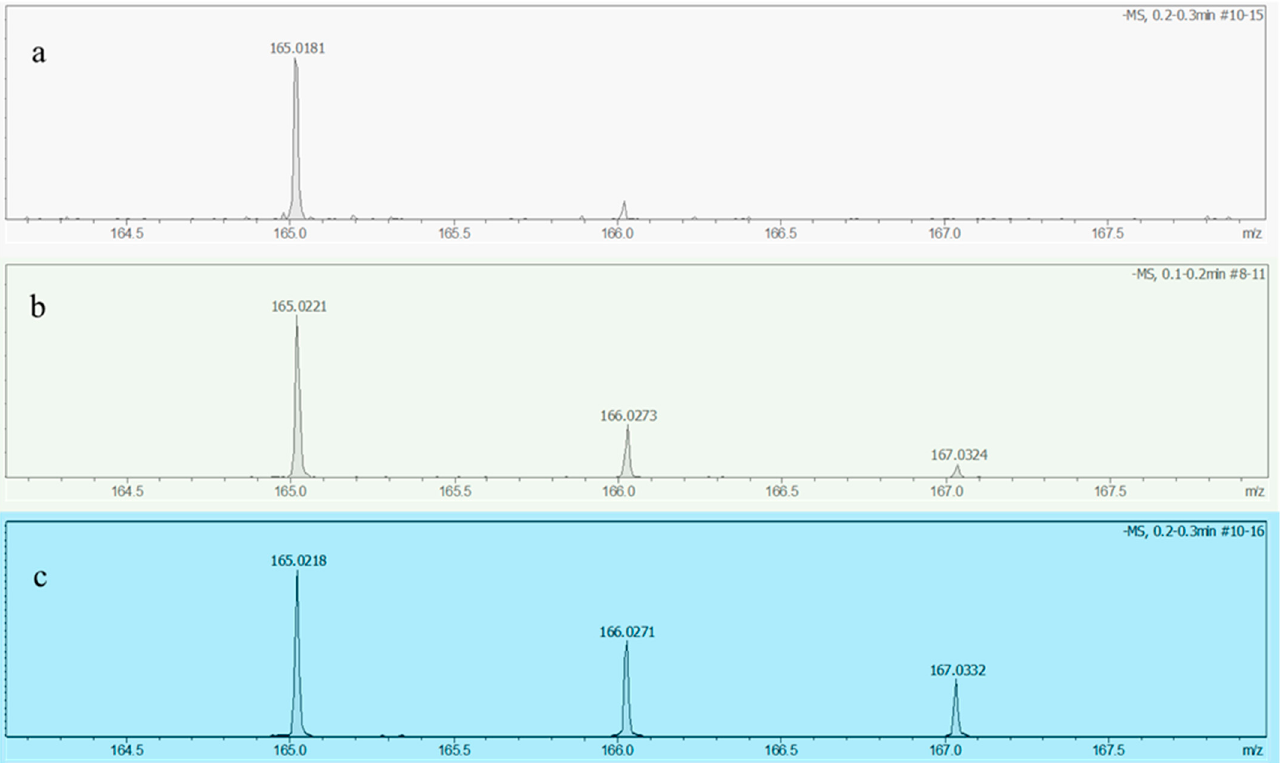
Figure 8. ESI–MS analysis of TPA obtained under different conditions: ( a ) TPA obtained by catalytic steam–assisted (H 2 O) pyrolysis of PET; ( b ) TPA obtained by steam-assisted (D 2 O) pyrolysis of PET without catalyst; ( c ) TPA obtained by catalytic steam-assisted (D 2 O) pyrolysis of PET.